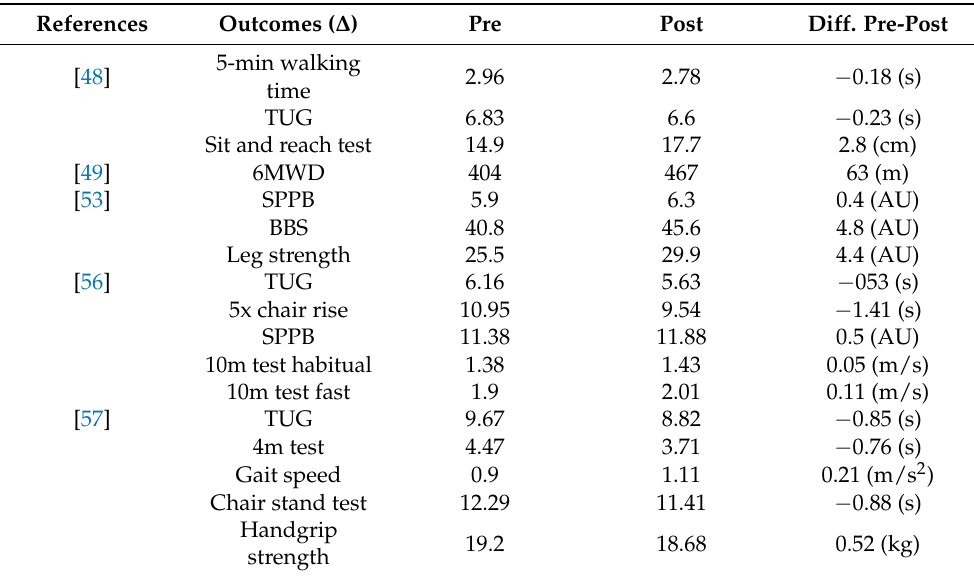
Table 4. The main outcomes of chronic diseases before